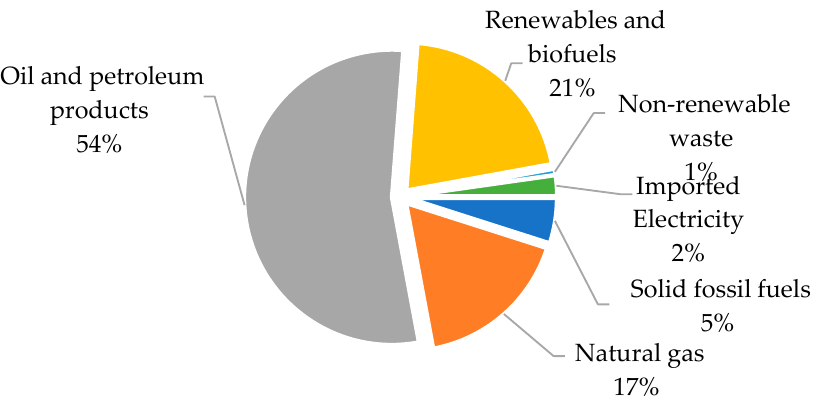
Figure 11. Portuguese energy mixes available in 2019 from all sources (adopted from Eurostat data).